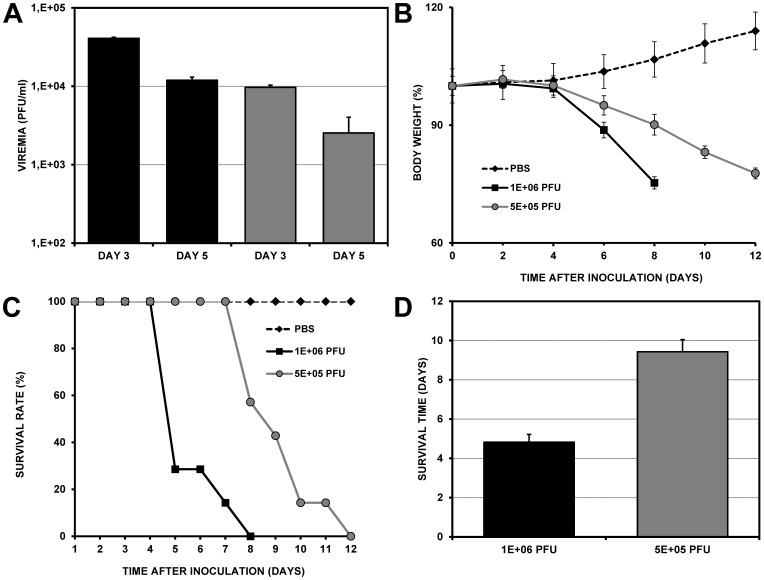
Effect of viral dose on viremia and survival rate of AG129 mice.Groups of six mice were inoculated intraperitoneally with a high viral dose of 1×106 PFU/ml (dark bars) or a low viral dose of 1×105 PFU/ml (grey bars) to determine the optimal dose of infection and time of occurrence of the highest levels of viremia. A. Plaque assay of infected VERO cells to quantify serum viremia at 3 and 5 dpi. Bars represent the standard error of the mean (SEM). B. Average body weight percentage, recorded every two days until the animals died or were sacrificed. C. Kaplan-Meier curve showing the survival rates of both groups from day 0 to day 12. D. Comparison of the survival rates of the two groups. Mice inoculated with 1×106 PFU/ml developed higher levels of viremia at day 3.